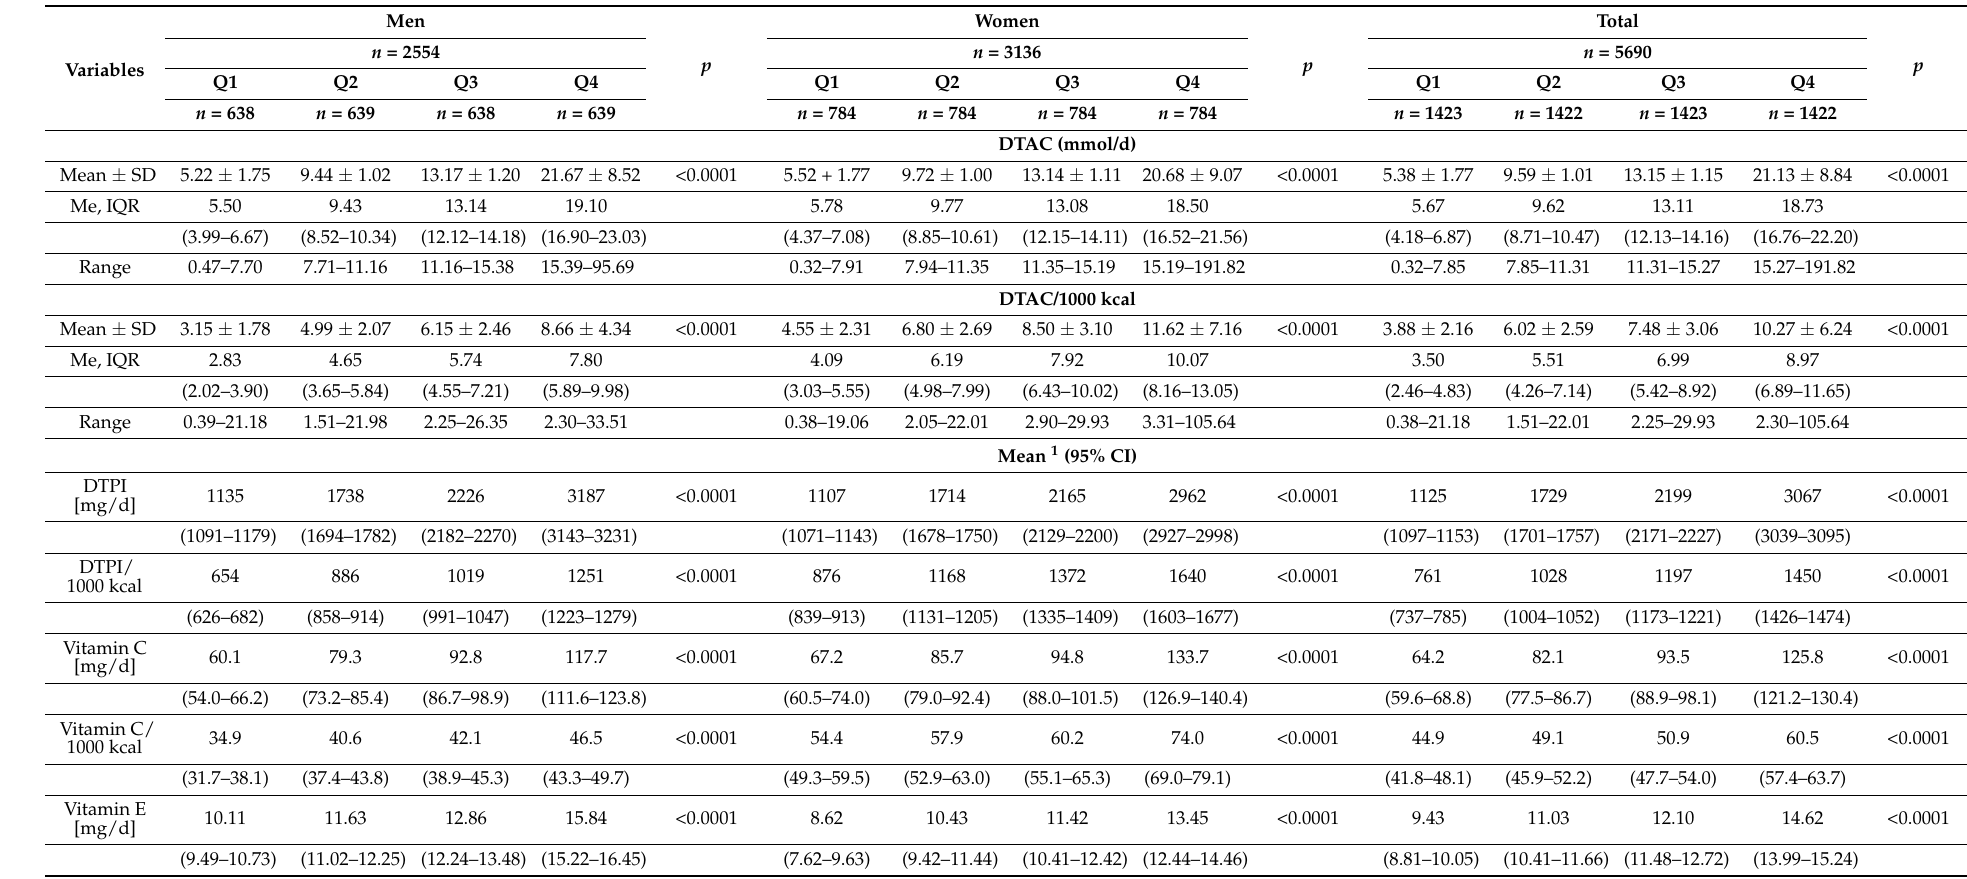
Table 3. Antioxidant intake from food and supplements by quartiles of DTAC according to sex and